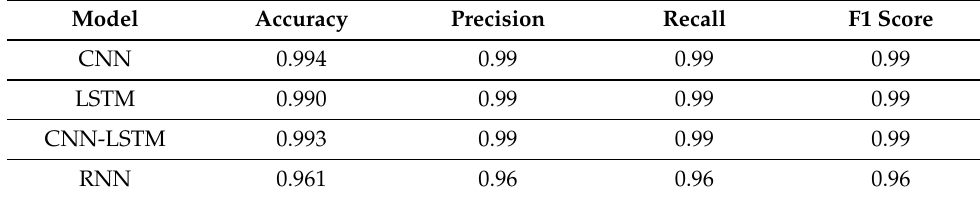
Table 13. Performance of deep learning models using multi-features with 50 k